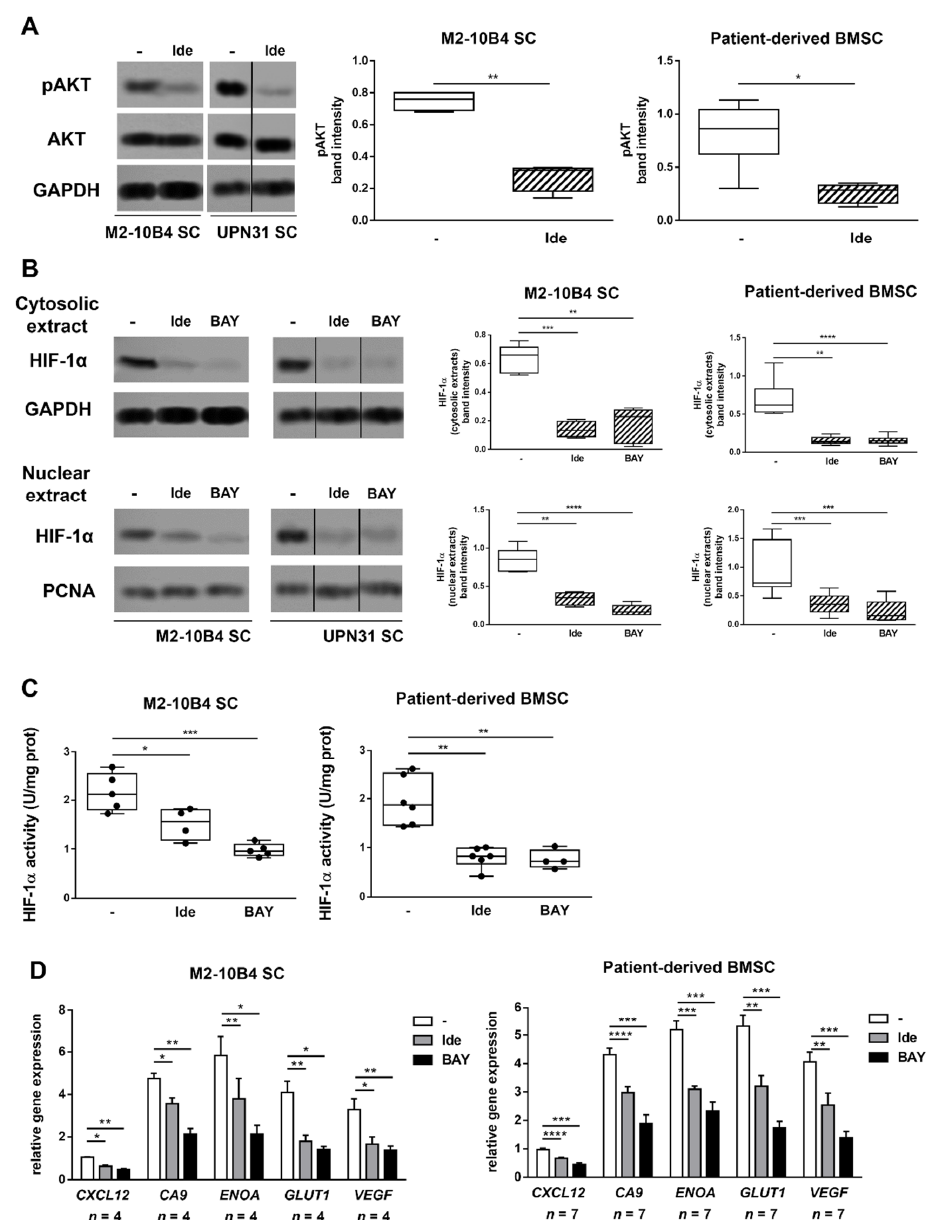
Figure 4. The targeting of PI3K/AKT signalling pathway downmodulates HIF-1 α and its target genes expression in SC. M2-10B4 SC and patient-derived BMSC were cultured in absence or in presence of idelalisib (Ide) or BAY87-2243 (BAY) for 48 h. Idelalisib effectively inhibits pAKT expression in SC ( A ). Both drugs induced a decrease in cytosolic and nuclear HIF-1 α expression ( B ), and in HIF-1 α activity ( C ) after 48 h culture. CXCL12 , CA9 , ENOA , GLUT1 and VEGF mRNA were also quantified, showing that idelalisib and BAY87-2243 significantly reduced HIF-1 α target genes’ expression in SC ( D ). In ( A ), a representative blot (with relative UPN, when applicable) with cumulative band intensity data obtained from the analysis of 4 replicates for M2-10B4 SC and 7 patient-derived BMSC independent experiments is shown. In ( B ), a representative blot (with UPN, when applicable) with cumulative band intensity data obtained from the analysis of 6 replicates for M2-10B4 SC and 11 patient-derived BMSC independent experiments is shown. In ( A – C ) box and whiskers plots show median values, 25–75% percentiles and minimum and maximum values for each group. In ( C ) each point represents one experiment with M2-10B4 SC ( n = 5) or one patient-derived SC sample ( n = 6). In ( D ), bar graphs represent mean results obtained from the analysis of 4 replicates for M2-10B4 SC and 7 patient-derived BMSC independent experiments, together with SEM. Repositioned gel lanes are indicated by vertical lines. **** p < 0.0001, *** p < 0.001, ** p < 0.01 and * p < 0.05. Please find the whole western blot in the Supplementary File